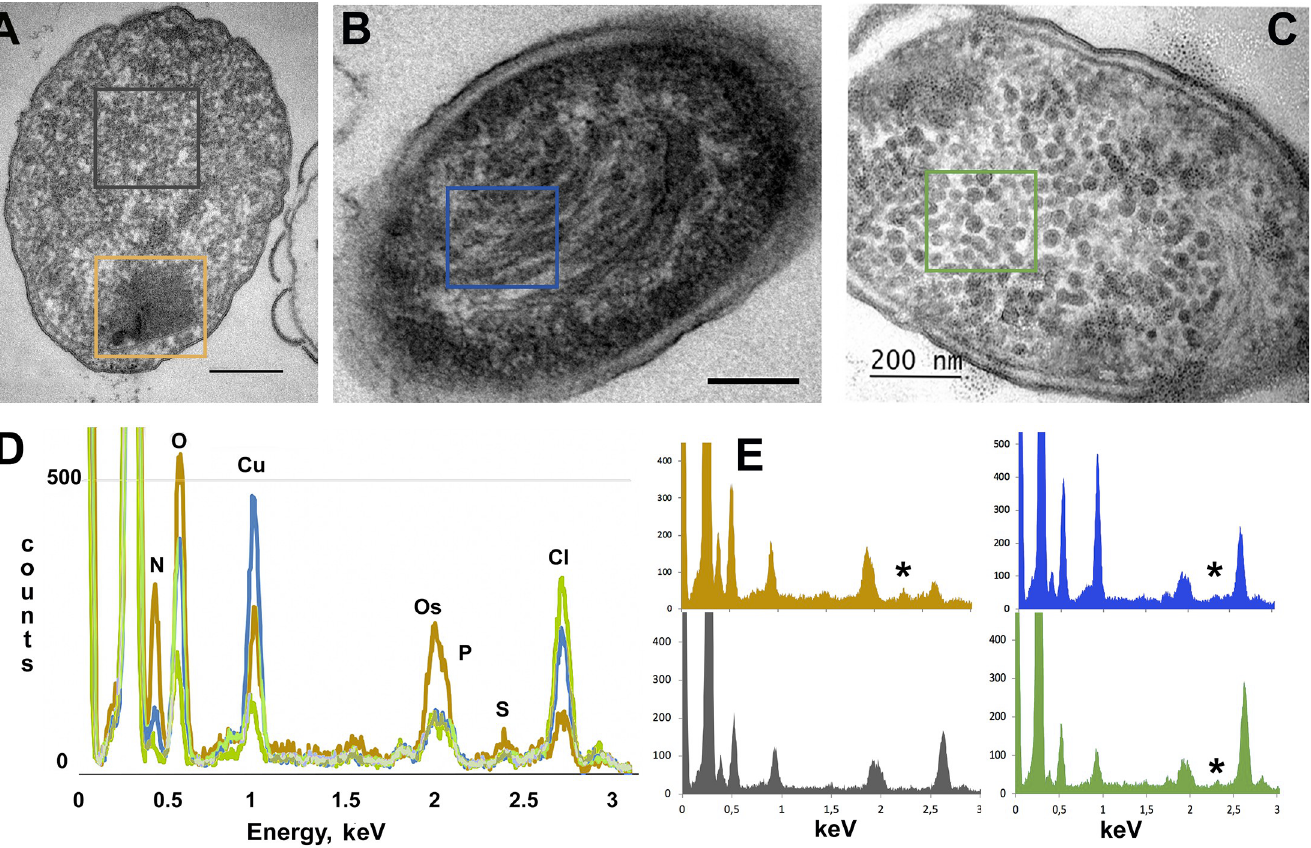
Fig 2. Three types of condensed DNA-Dps structures were found in dormant E . coli cells, starving for 7 months. (A) nanocrystalline ; (B) liquid crystalline ; (C) folded nucleosome-like type. Bar– 200 nm. Colored frames mark the specific areas, where the EDX spectra were obtained; (D) Superimposed EDX spectra from the selected areas, marked in (A-D), normalized to the C peak. Line colors reflect the corresponded frame colors in (A-D). (E) EDX spectra from the selected areas marked in (A-D), colored by the specific area. Asterisks mark positions of S